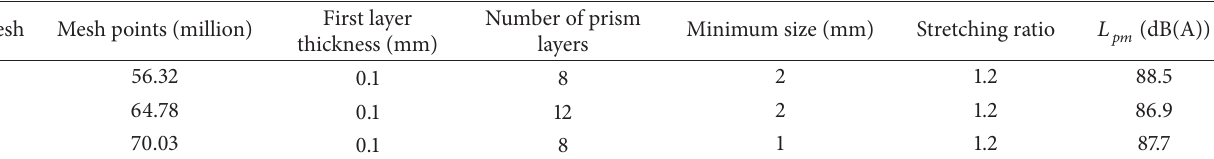
Figure 1: The geometric model: (a) the full vehicle and (b) the original pantograph fairing Dlz1. Table 1: Mesh configurations and computational results.